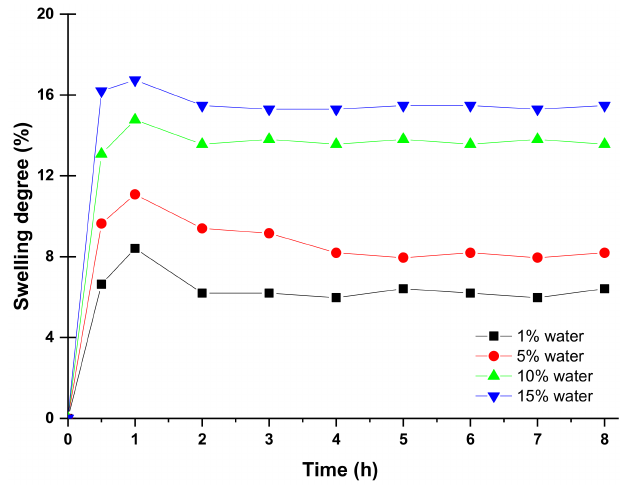
Figure 3. Swelling behavior of PVA10 as a function of water content in the